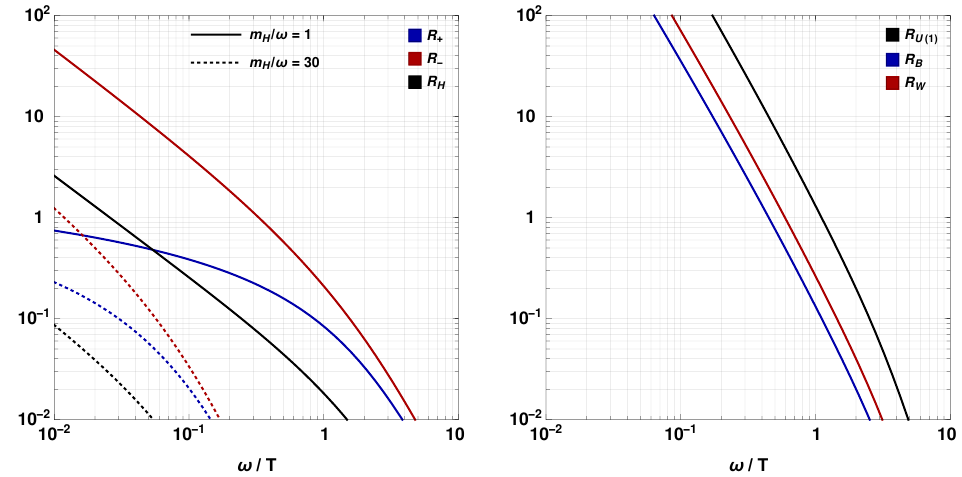
and R factors of eqs. (4.25) B W